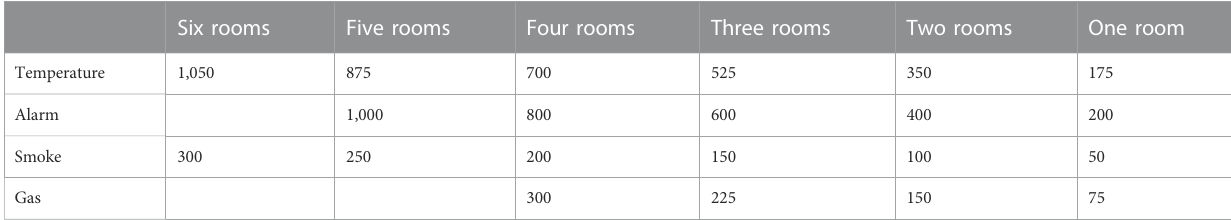
TABLE 5 Sample numbers of each calculation.